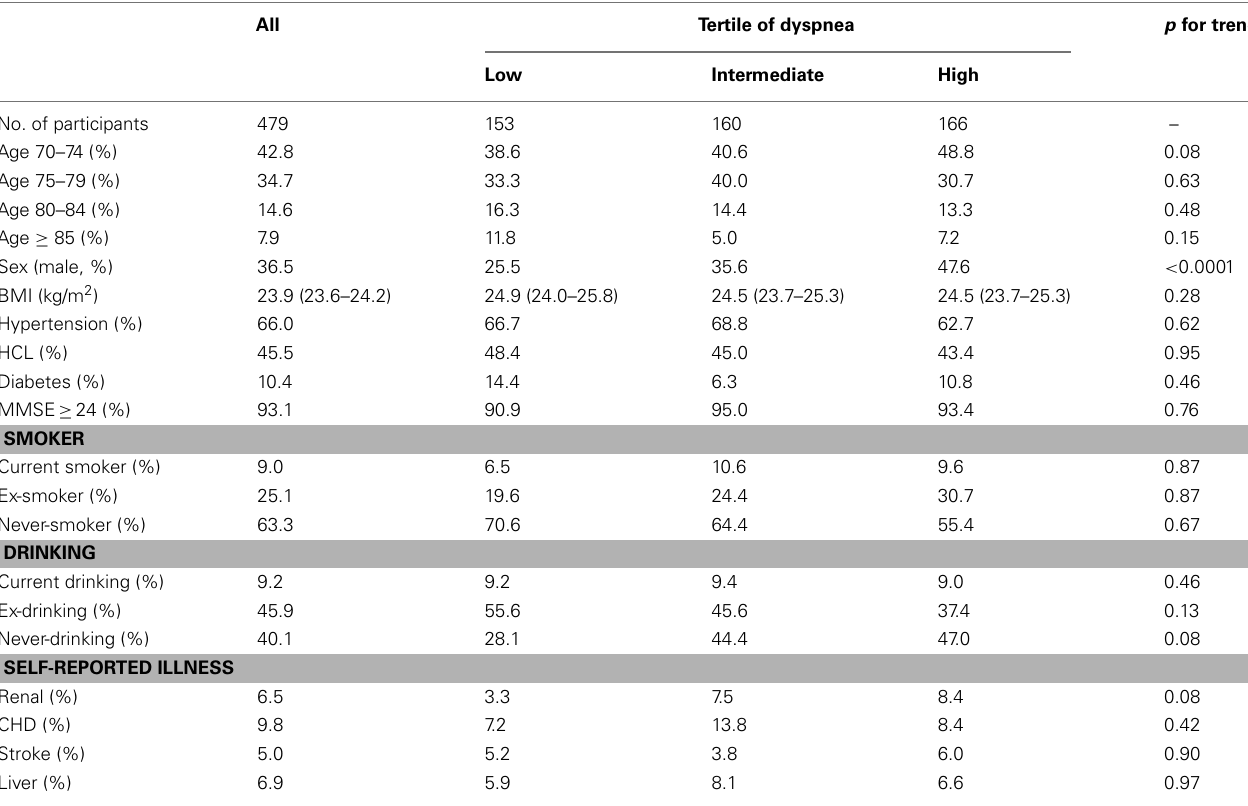
Table 1 | Baseline characteristics according to dyspnea tertile ( n = 479).